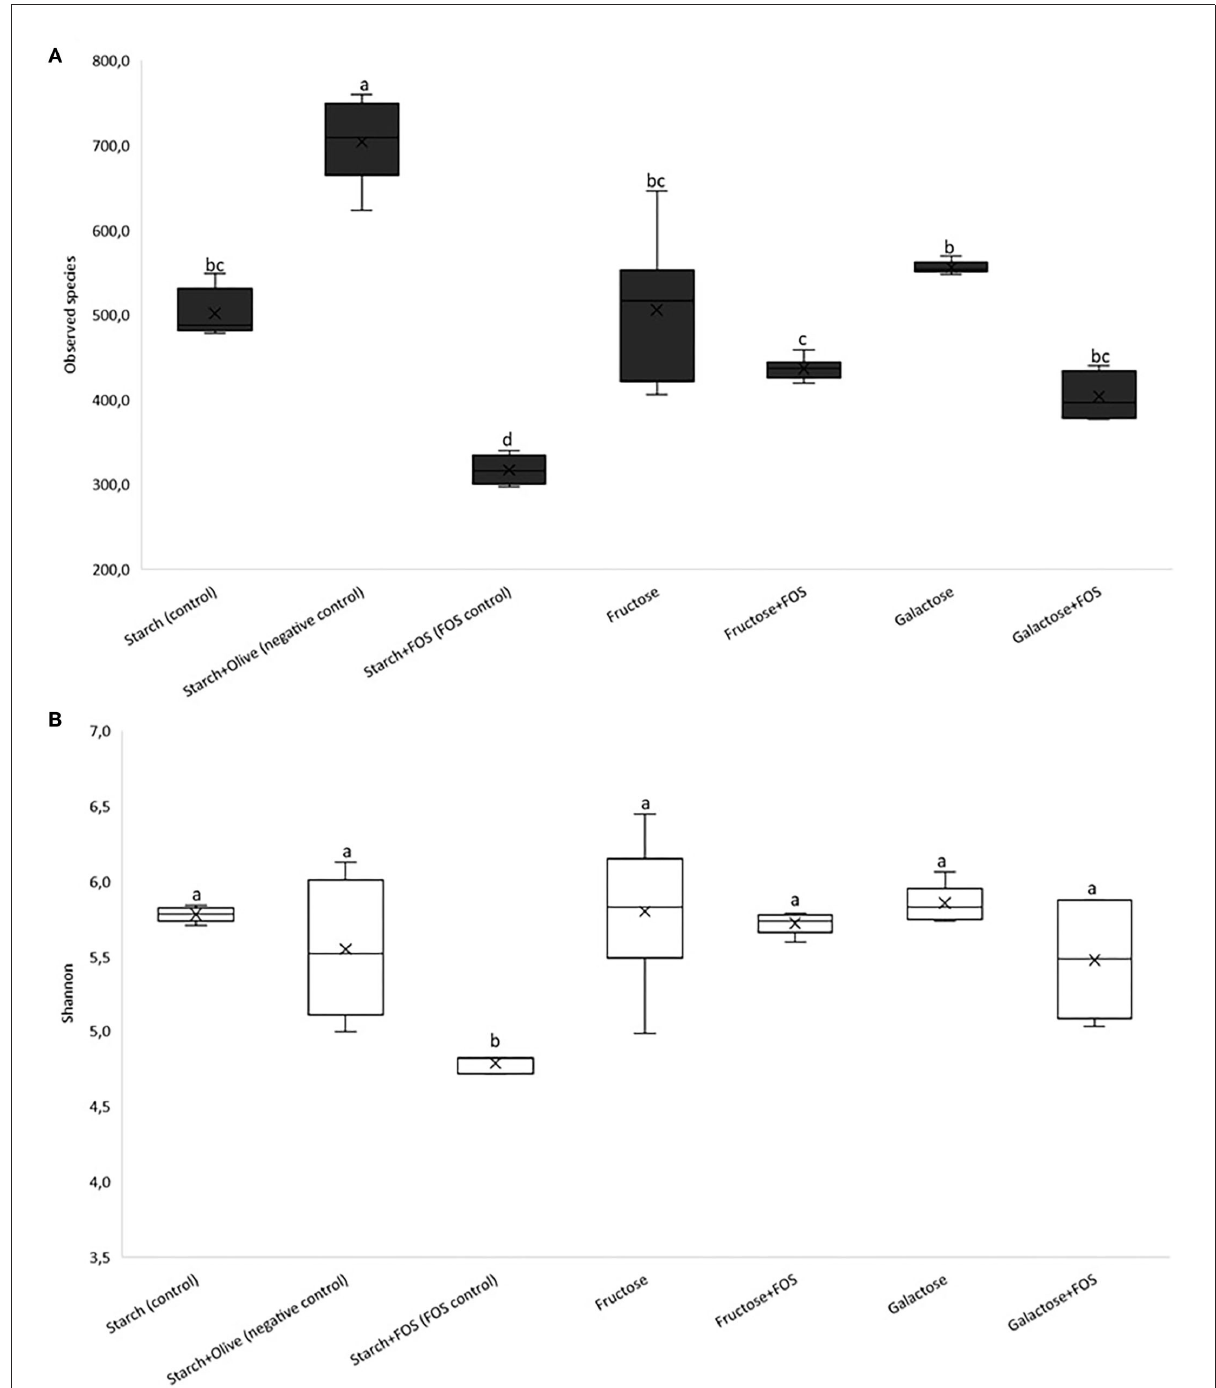
FIGURE1 Results of 16S rRNA gene sequence analysis of the gut microbiota community in the large intestine of rats fed a control diet (starch, starch + FOS, starch + olive) or a high-fructose or high-galactose diet, with and without added fructooligosaccharides (FOS), after 12 weeks. Alpha diversity; (A) observed species, (B) Shannon’s diversity index. Values shown are LS mean ± SEM of six rats. Groups were assessed by one-way ANOVA followed by Tukey’s test. Means with different superscripts (lowercase letters) differ significantly ( p <